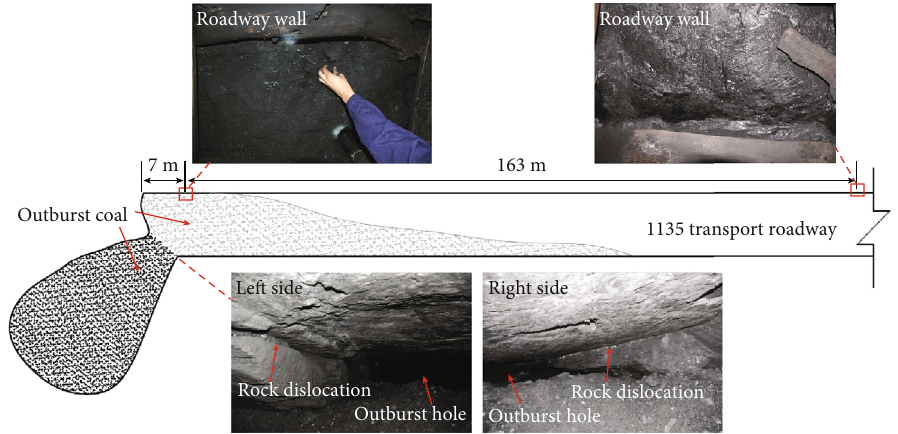
Figure 3: Field investigation features of outbursts in the Xiangshui Coal Mine.